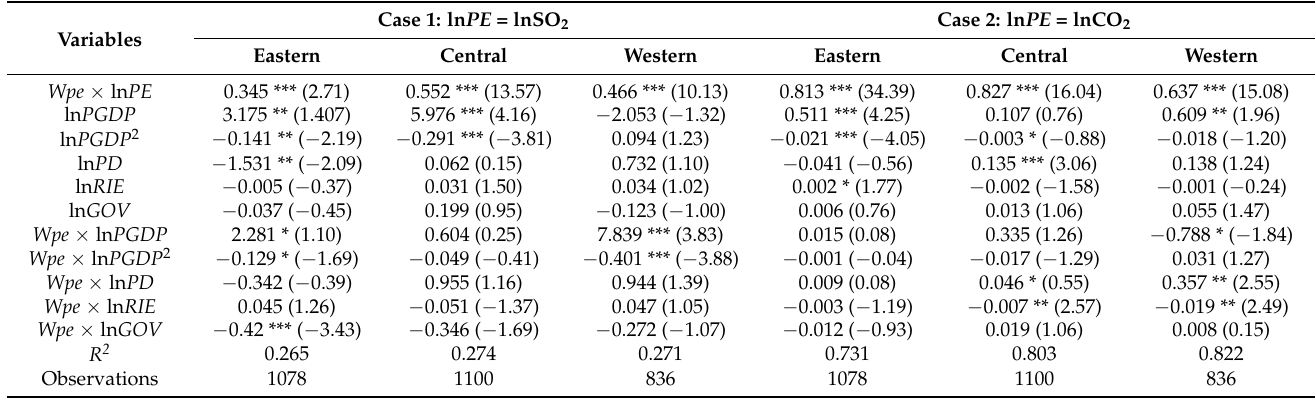
Table 6. Estimation results of two-way FE SDM models based on regional